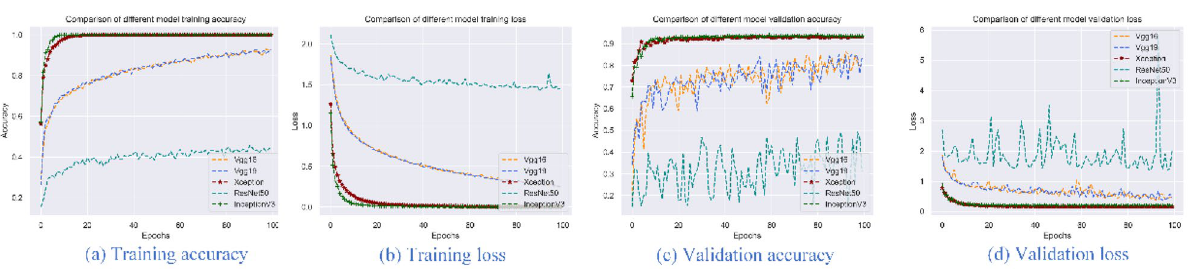
Figure 3. Accuracy and loss for five different models using image_trans data.